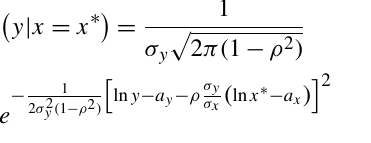
Equation (7) is still a Log normal distribution func- tion. The mathematical expectation value of ln( y ) is a y +